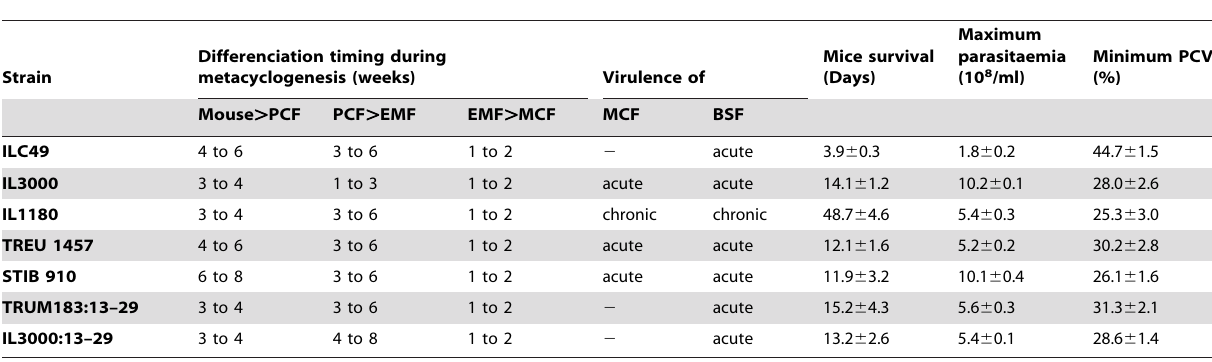
Table 3. In vitro cycle timing and virulence of various T. congolense strains.